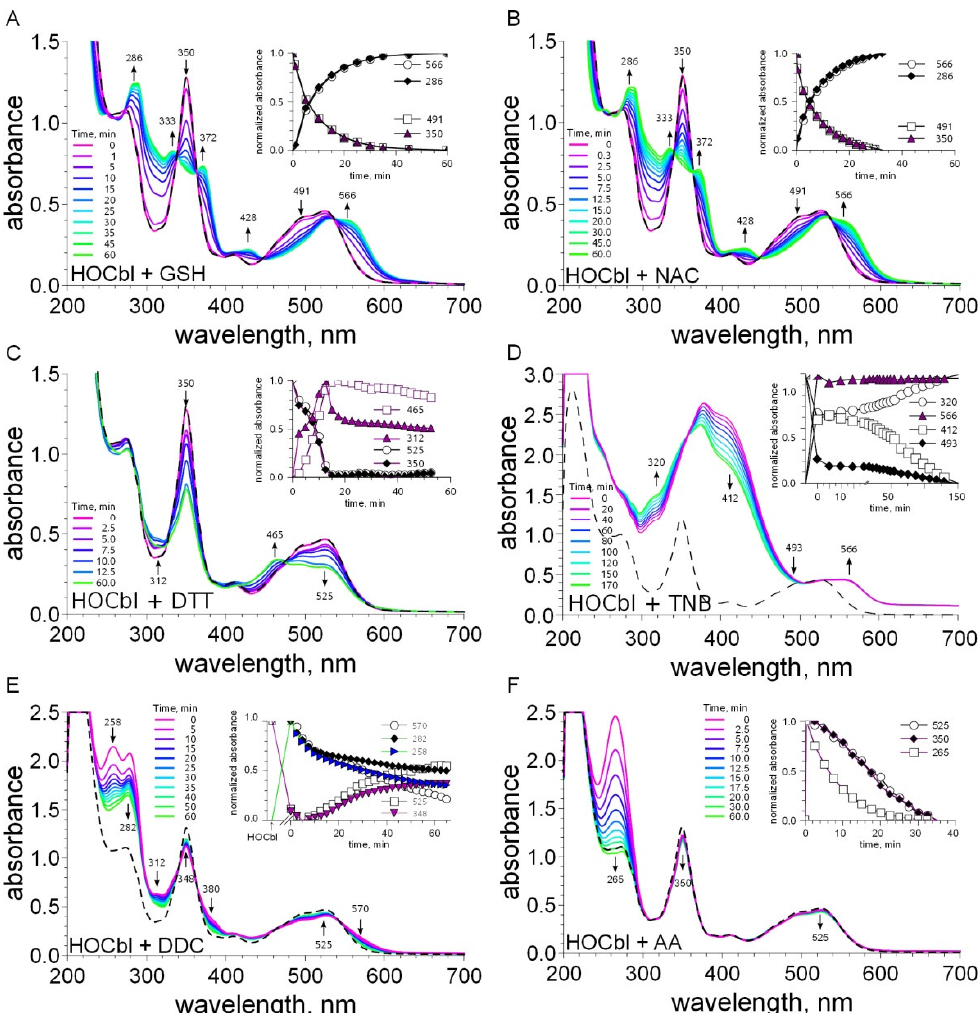
Figure 4. UV-Vis spectra recorded in the reactions between H 2 OCbl + /HOCbl and compounds being tested: ( A ) GSH, ( B ) NAC, ( C ) DTT, ( D ) TNB, ( E ) DDC, ( F ) AA. Dashed lines indicate the spectrum of H 2 OCbl + /HOCbl. Inserts: kinetic traces recorded in the corresponding reactions at selected wavelengths.